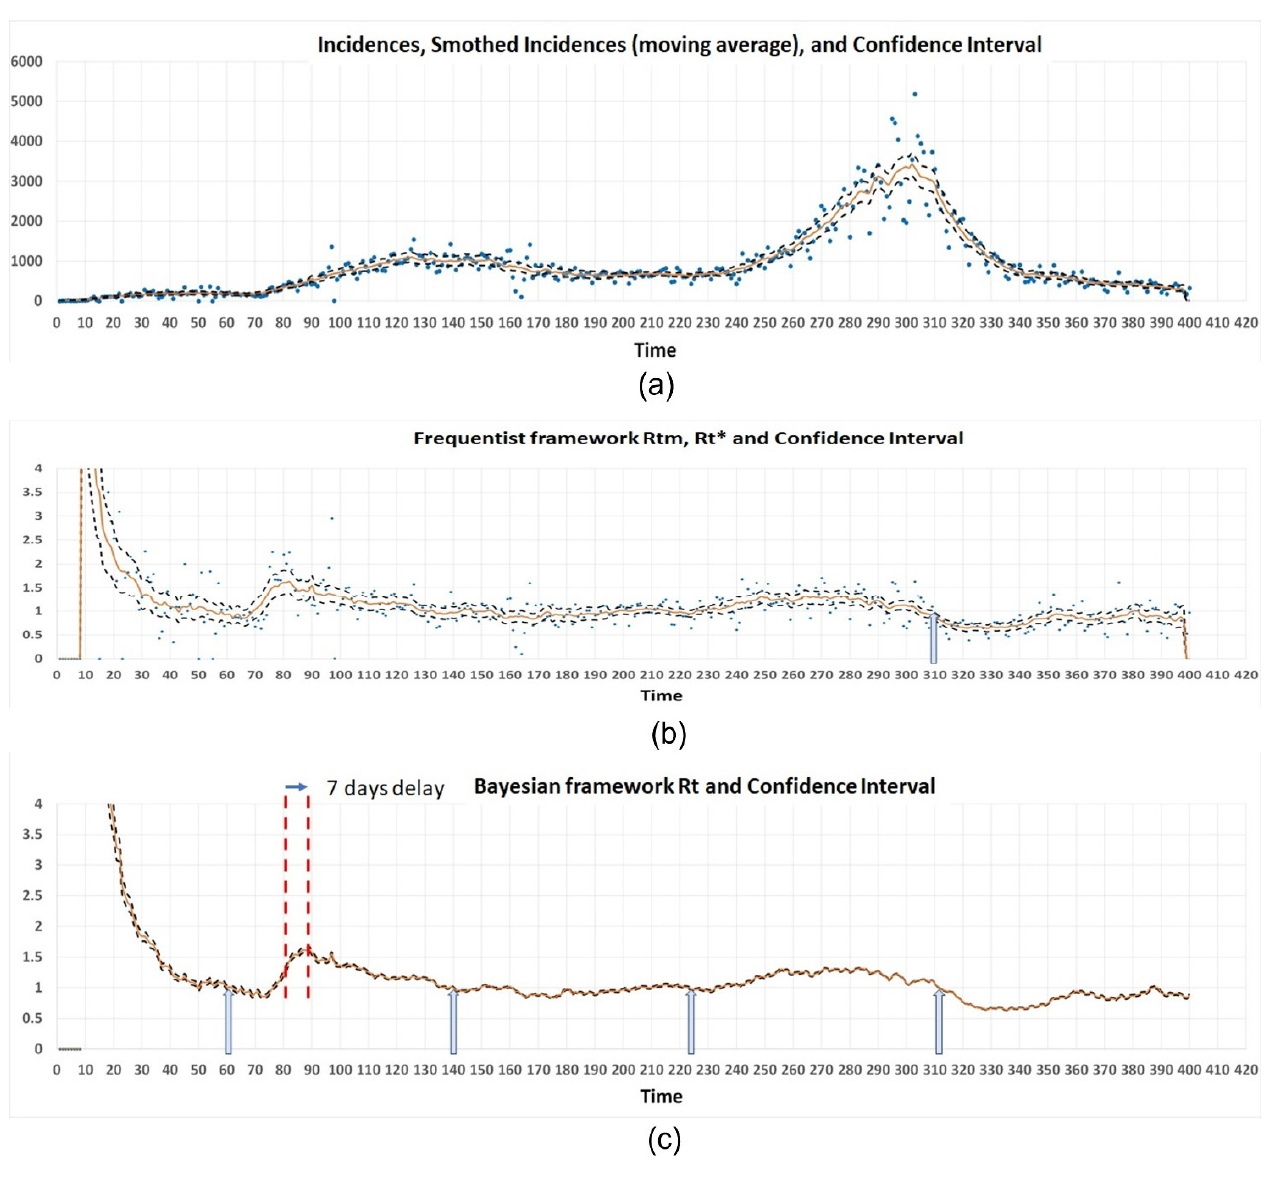
Figure 13. Partial data of the COVID-19 pandemic, Panama (9 March 2020–12 April 2021): ( a ) Inci- dence data series; ( b ) Frequentist framework 𝑅 (cid:3047)(cid:3040) , with its 95% confidence interval; and ( c ) Bayesian framework 𝑅 (cid:3047) , with its 95% confidence interval.